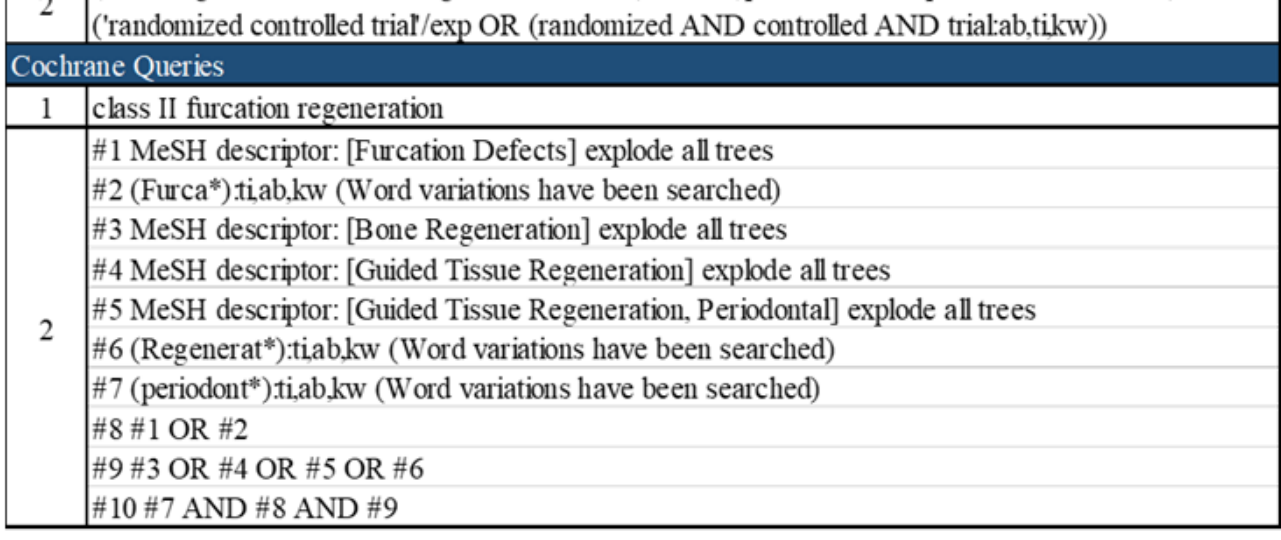
Figure 1. Queries and MESH terms used on three databases.